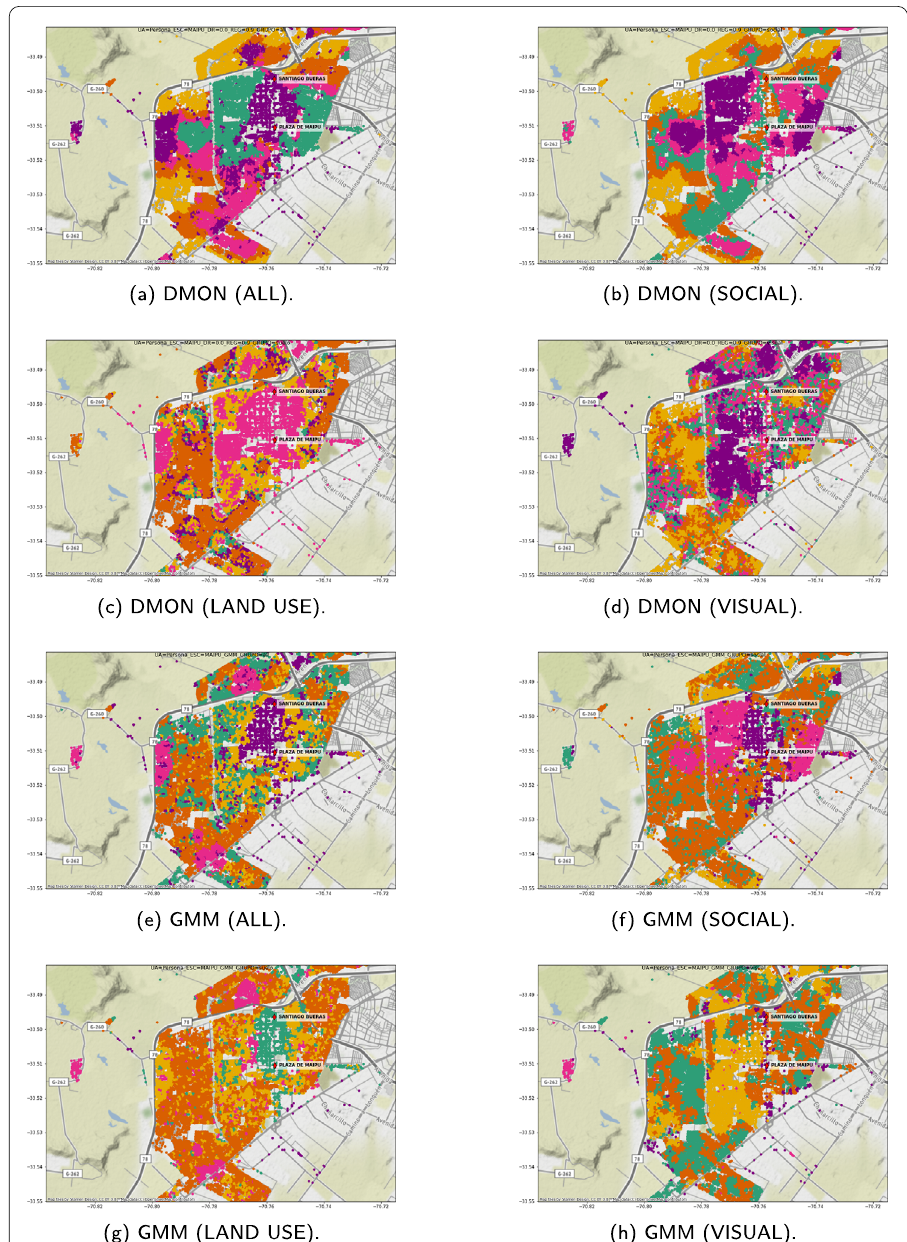
Figure 5 Maps for a low segregation area (Maipú). DMON using ALL as SOCIAL features, detects the residential area, clustering Villa Los Héroes precisely. This Villa has a circular shape almost in the middle of the map. When using LAND USE or VISUAL, this cluster disappears. The GMM map that makes the best territorial sense also uses SOCIAL features. All maps were generated at the level of individuals